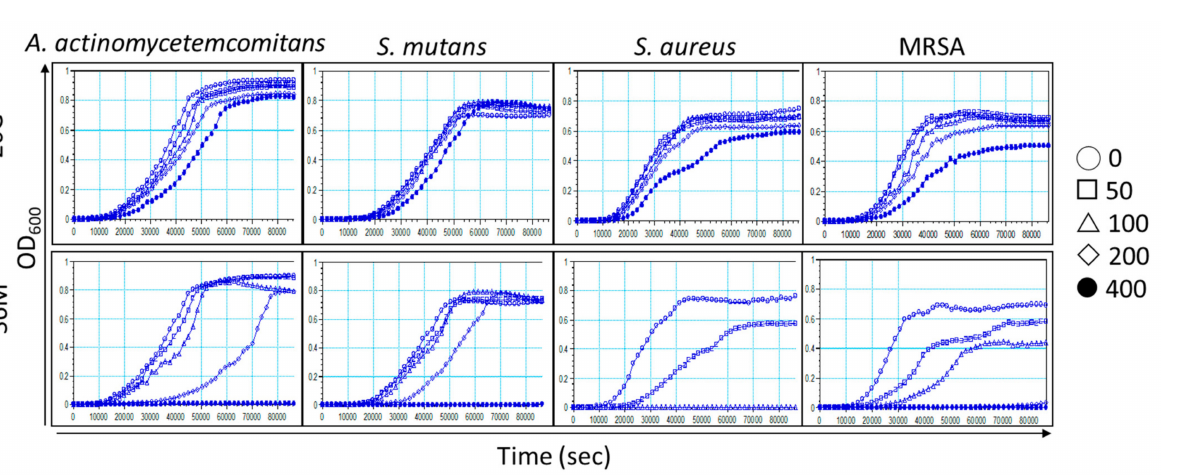
Figure 3. Both 26G and 36M delayed the growth of microorganisms in a concentration-dependent manner. The vehicle (DMSO) and various concentrations (50–400 µ M) of 26G and 36M were used to evaluate their impact on the bacterial growth curves. Y -axis, OD600; X -axis, time